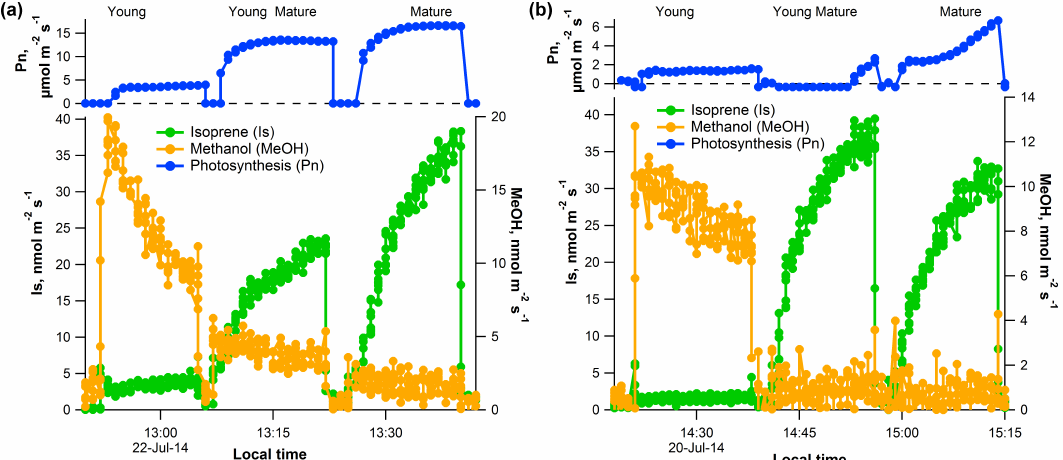
Figure 4. Example leaf age experiments of net photosynthesis (Pn, blue circles), methanol emissions (MeOH, orange circles) and isoprene emissions (Is, green circles) from two V. guianensis individuals. For each plant shown in panels (a) and (b) a young, young mature, and mature leaf were sequentially placed in the leaf enclosure for 15min each after exposed to laboratory conditions following transport from the field. Throughout the leaf age experiments, PAR, leaf temperature, and reference [CO 2 ] were held constant at 1000µmolm − 2 s − 1 , 30 ◦ C, and 400ppm, respectively. Pn was determined by a portable photosynthesis system (LI-6400XT, LI-COR Inc., USA). Is and MeOH were